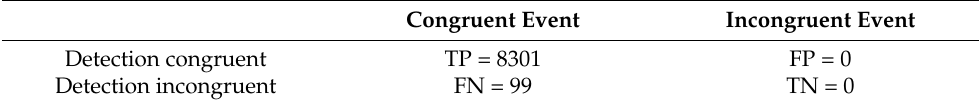
Table 11. Contingency table that assists with the detection of congruences in the Landsat 8 scene of the Doce River basin acquired in 2019 and consisting of 8400 tiles (TP—true positive, FP—false positive, FN—false negative, TN—true negative).